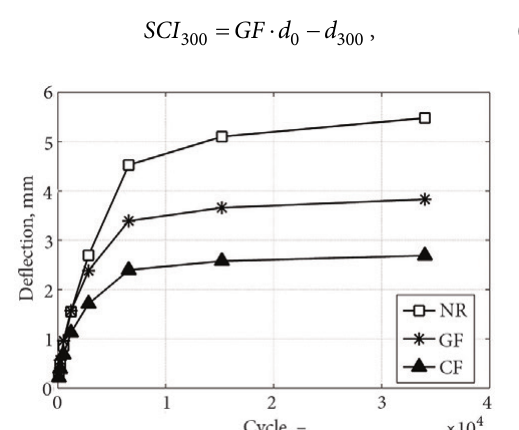
Fig. 3. History of beam deflections in cyclic testing